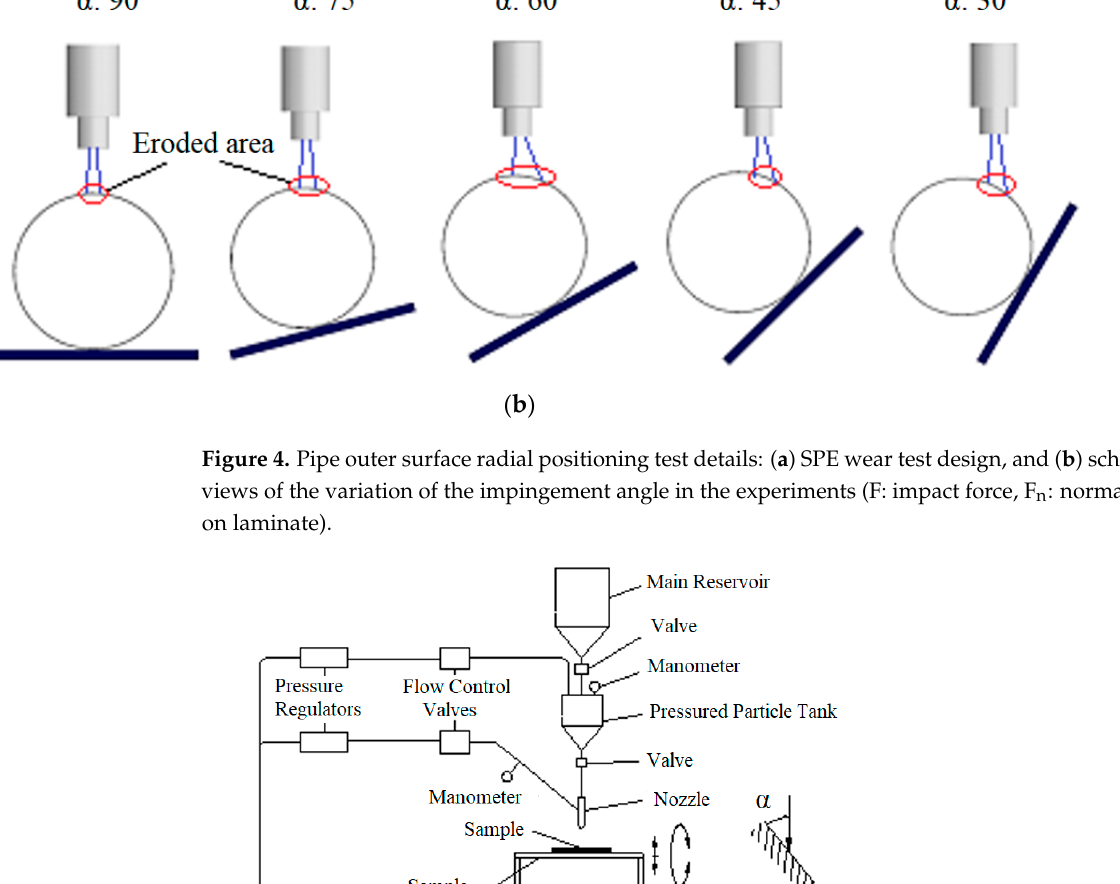
Figure 4. Pipe outer surface radial positioning test details: ( a ) SPE wear test design, and ( b ) sche- matic views of the variation of the impingement angle in the experiments (F: impact force, F n : nor- mal force on laminate).